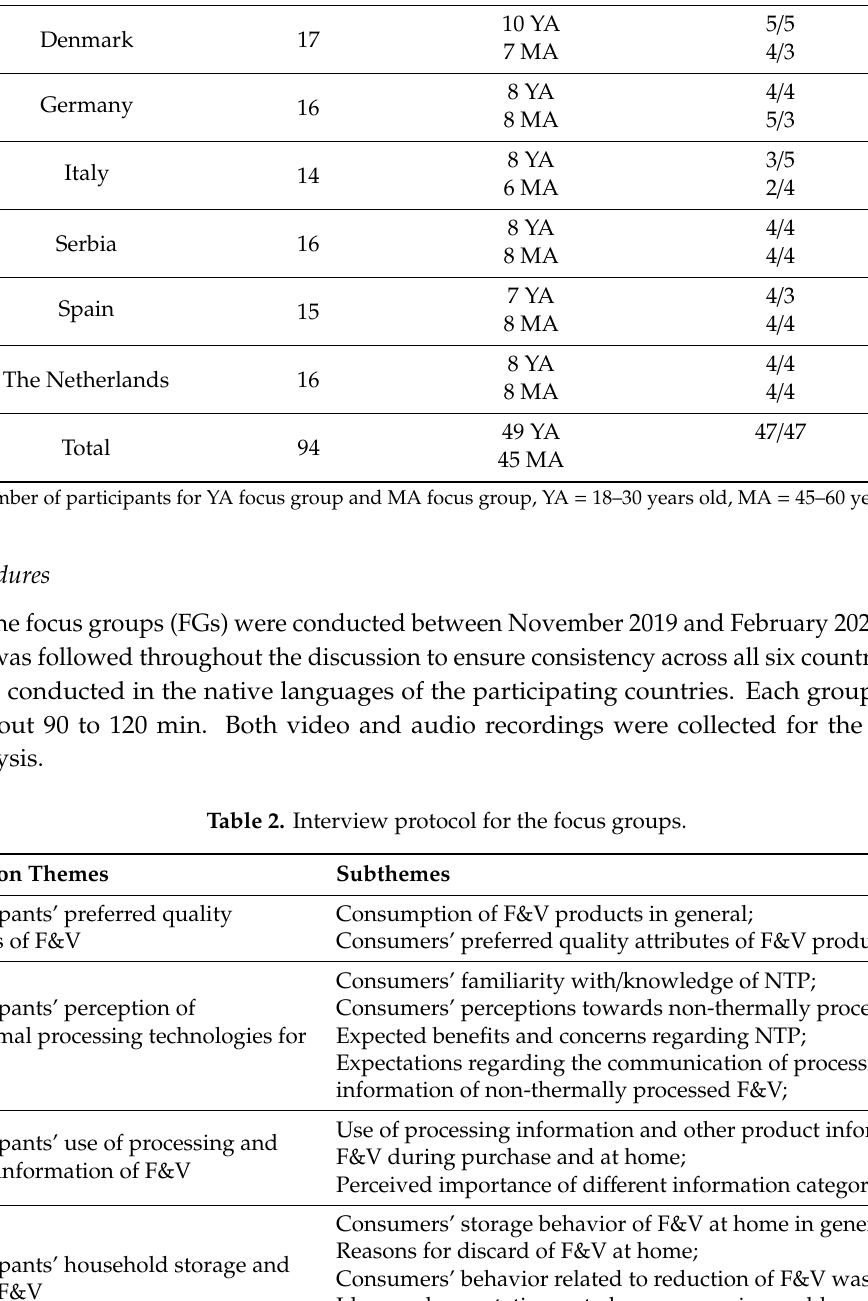
Table 1. Demographic information of the participants in the six participating countries. Country Participants (N)